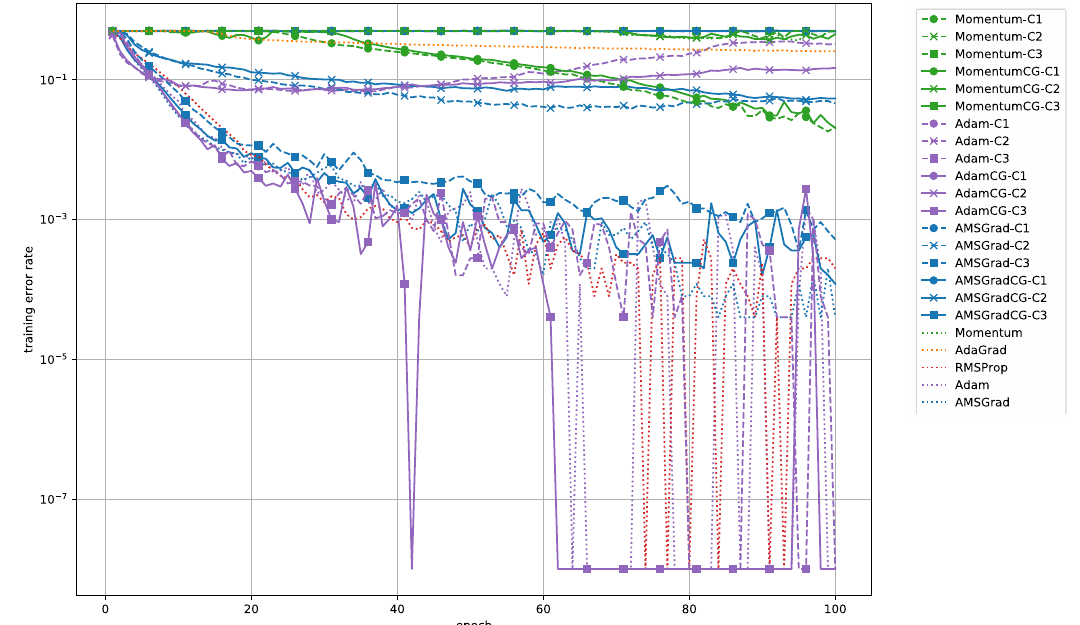
Figure 8. Classification error rate versus number of epochs on the IMDb dataset for training